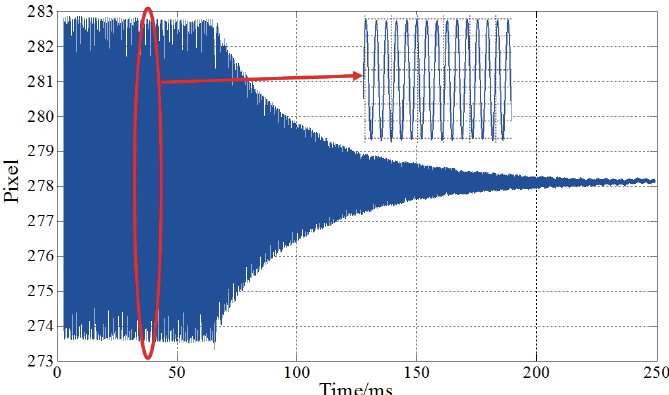
Figure 6. Measured amplitudes after excitation suddenly terminates.